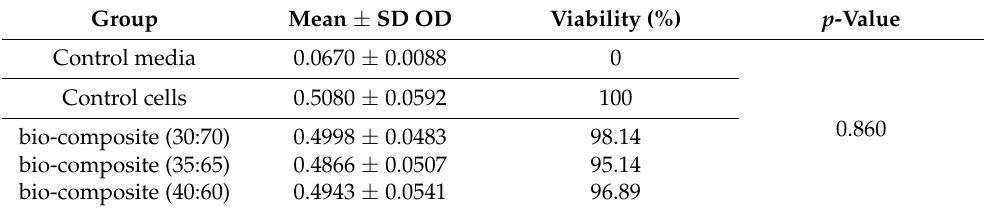
Table 2. The fibroblast viability of modified BAM and all types of bio-composites.